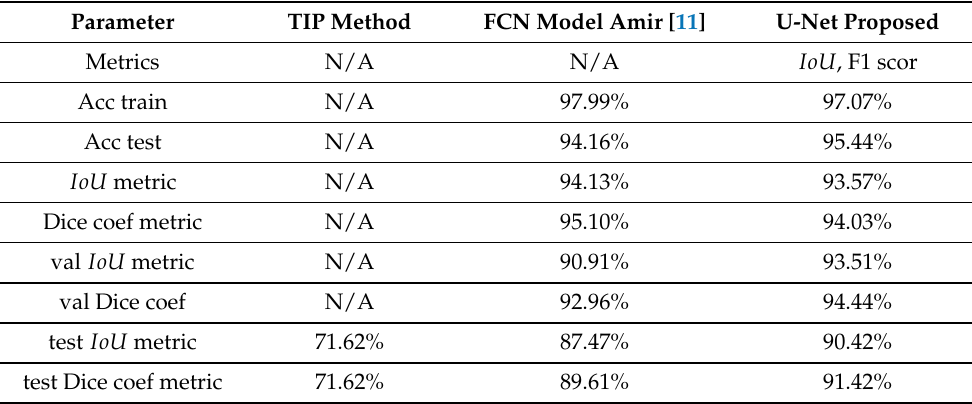
Table 3. Comparison between three